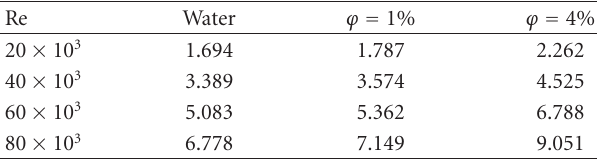
Table 3: Inlet velocities and Re.